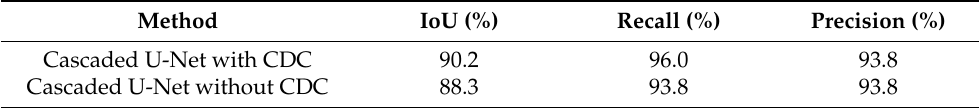
Table 9. Comparison between our model with or without the CDC.